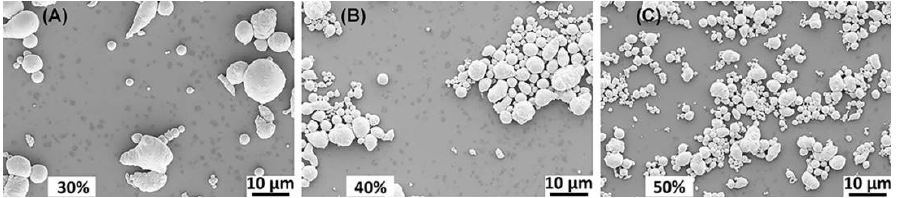
Figure 3. Morphology images of eGaIn nanodroplets under different ultrasonic amplitudes: ( A ) 30% ( B ) 40%, and ( C ) 50%.